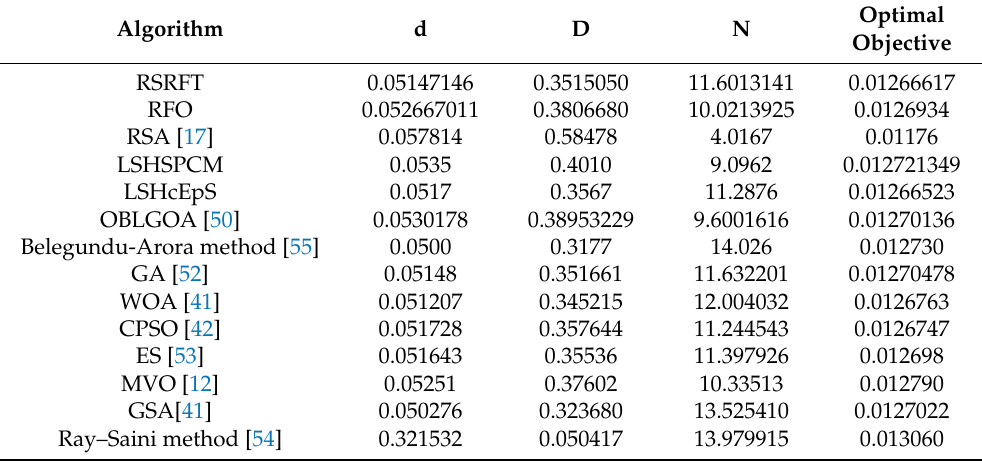
Table 2. The value of the estimated parameters using RSRFT and others to solve the TCSD